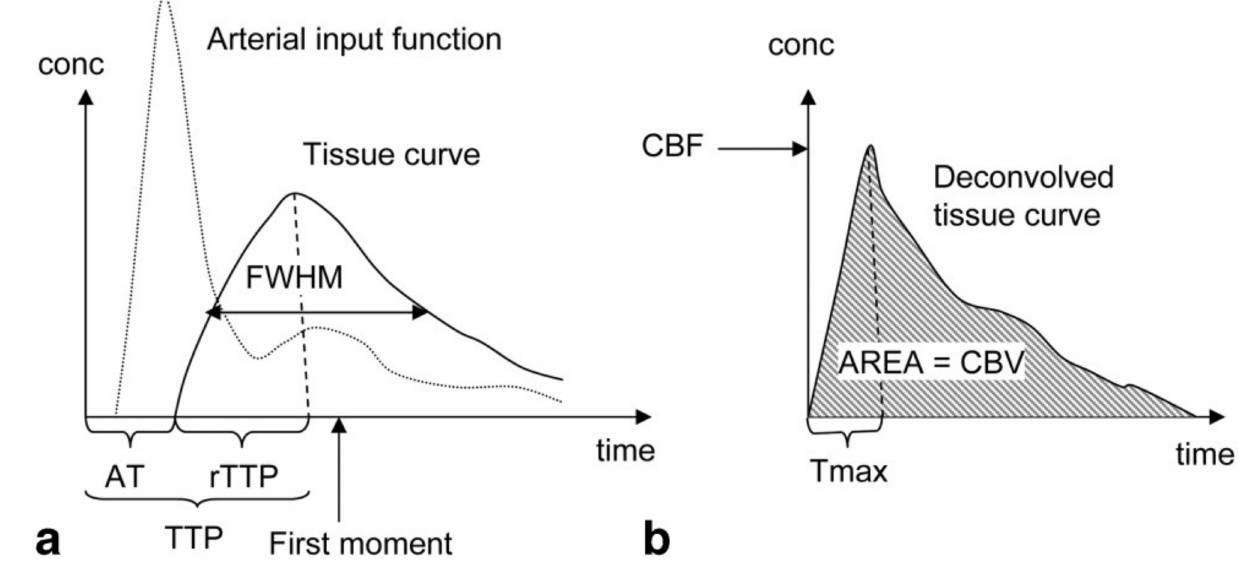
Figure 2. Parameters derivation in Dynamic Susceptibility Contrast Enhanced (DSC) MRI: ( a ) Semi-quantitative interpreta- tion can be derived from the signal intensity curve. The Arrival Time (AT) of the bolus can be determined from the time interval between the injection of the contrast agent and the time point where the contrast agent is first detected in the tissue. The Time-To-Peak (TTP) is determined by the time interval between the injection of the contrast agent and the peak of the contrast agent in the tissue. The Full Width at Half Maximum (FWHM) is dependent on the Mean Transit Time (MTT) of the tissue. ( b ) the contrast concentration curve can be calculated by deconvolution of the Arterial Input Function (AIF) and the signal intensity curve. The Cerebral Blood Flow (CBF) is determined by the maximum height of the contrast concentration curve (T max ). The Cerebral Blood Volume (CBV) is determined by the area under the contrast concentration curve, while the MTT can be calculated using MTT = CBV/CBF. Reproduced with permission from Leif Østergaard, Journal of Magnetic Resonance Imaging, published by John Wiley and Sons, 2005